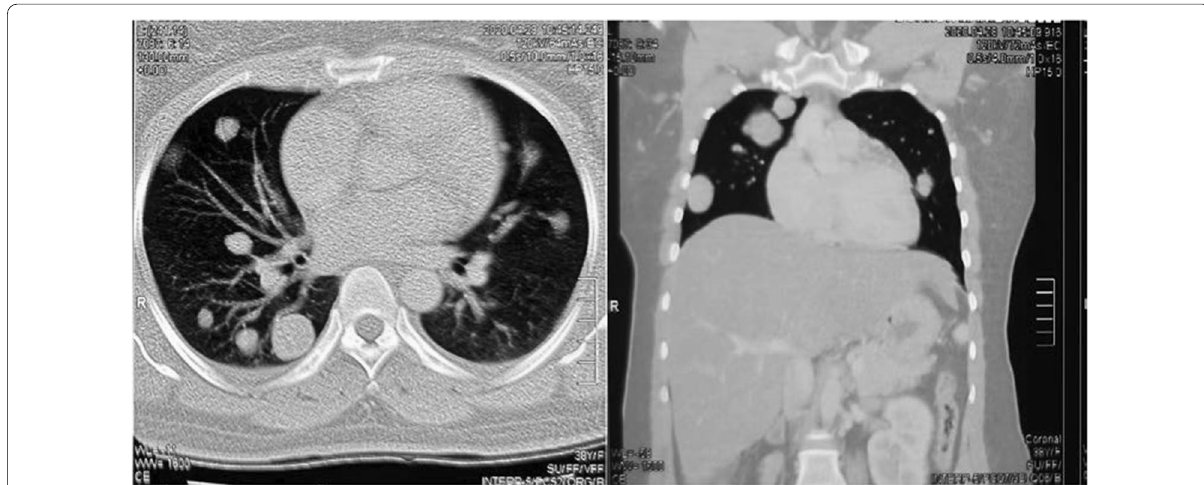
Fig. 5 Five‑year postoperative contrast‑enhancing CT images of the chest showing persisting multiple well‑defined enhancing lesions in both lung